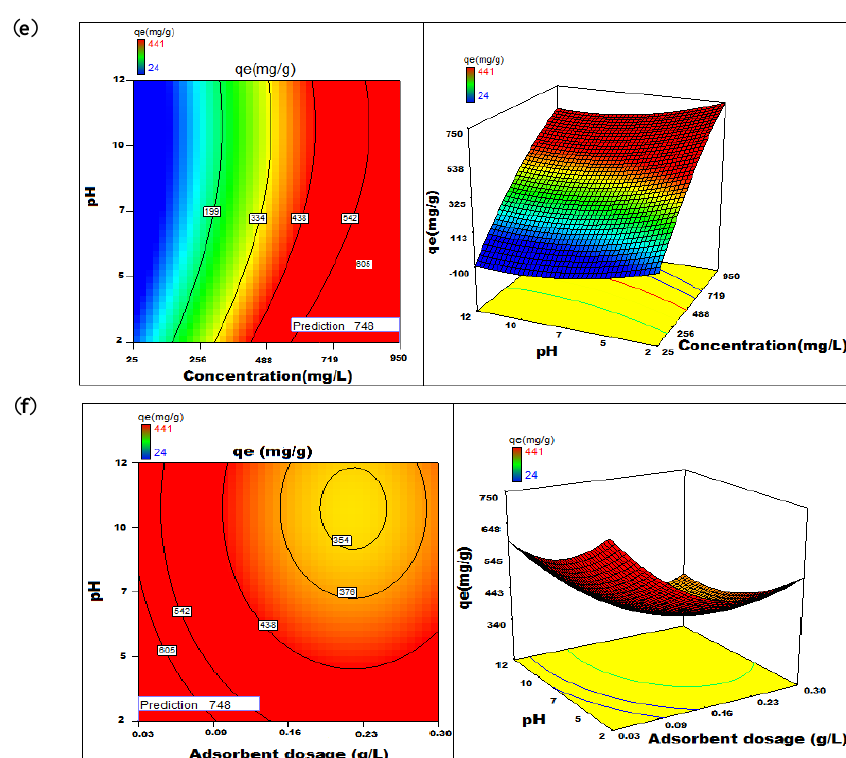
Figure 11. The 2D-contour and 3D-surface plots showing the variation of adsorption capacity with ( a ) temperature versus concentration, ( b ) temperature versus adsorbent dosage, ( c ) temperature versus pH, ( d ) concentration versus adsorbent dosage, ( e ) concentration versus pH and ( f ) adsorbent dosage versus pH.